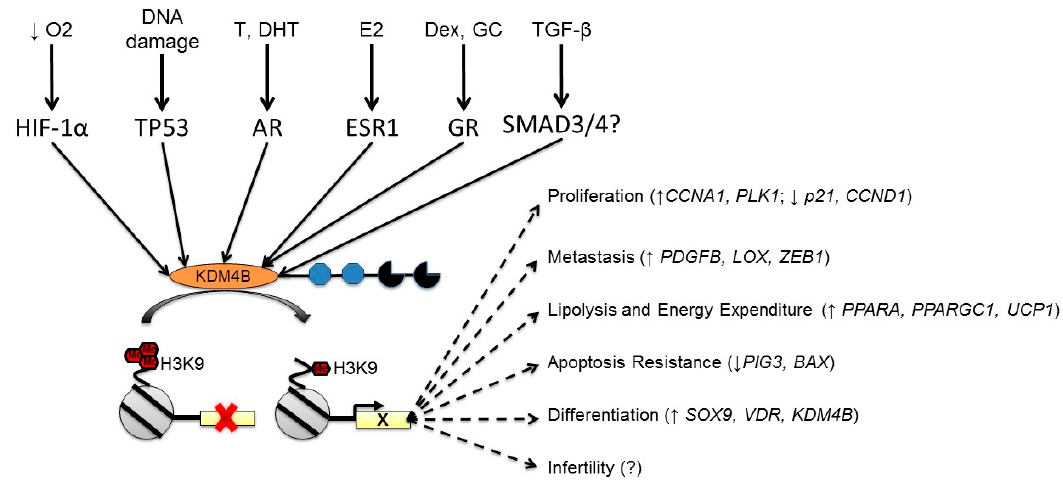
Figure 2. KDM4B integrates multiple cellular signals to affect biological processes. KDM4B is induced